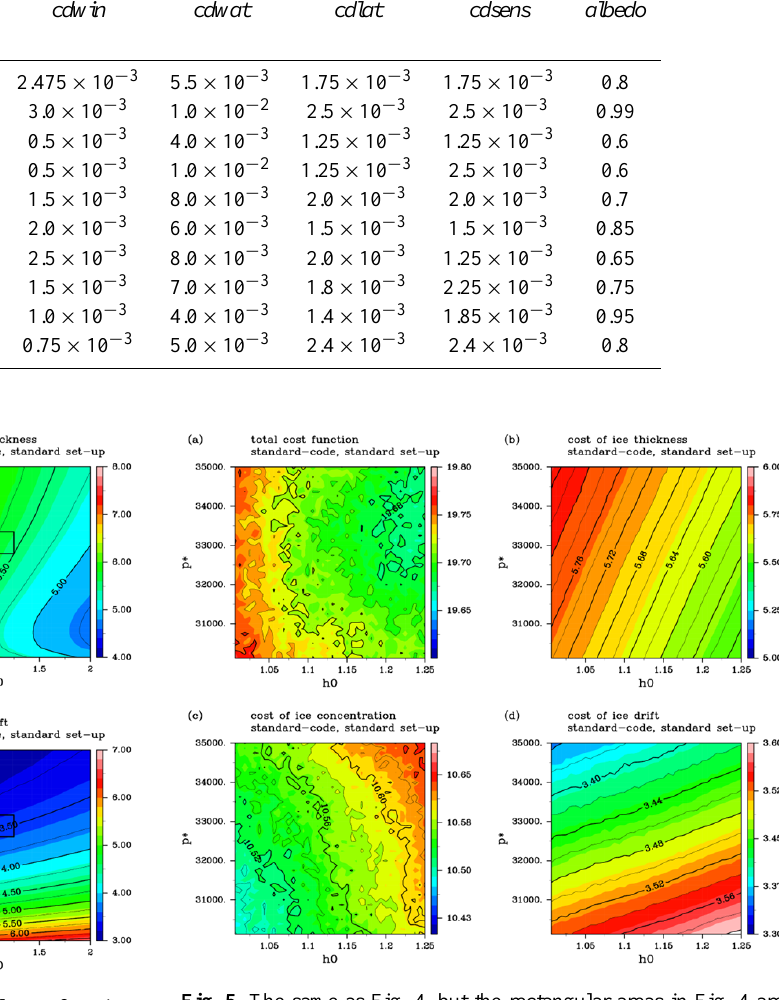
Fig. 4. (a) A two-dimensional structure of the total cost function in h 0 − P ∗ space obtained from the standard-code, and contribu- tion to the cost from (b) ice thickness, (c) ice concentration and (d) ice drift velocity. Note that the same contour interval is adopted in all the panels, whereas the color scale is different. The black solid rectangles around the center of the panel are the area for the magni- fications shown in Fig. 5.